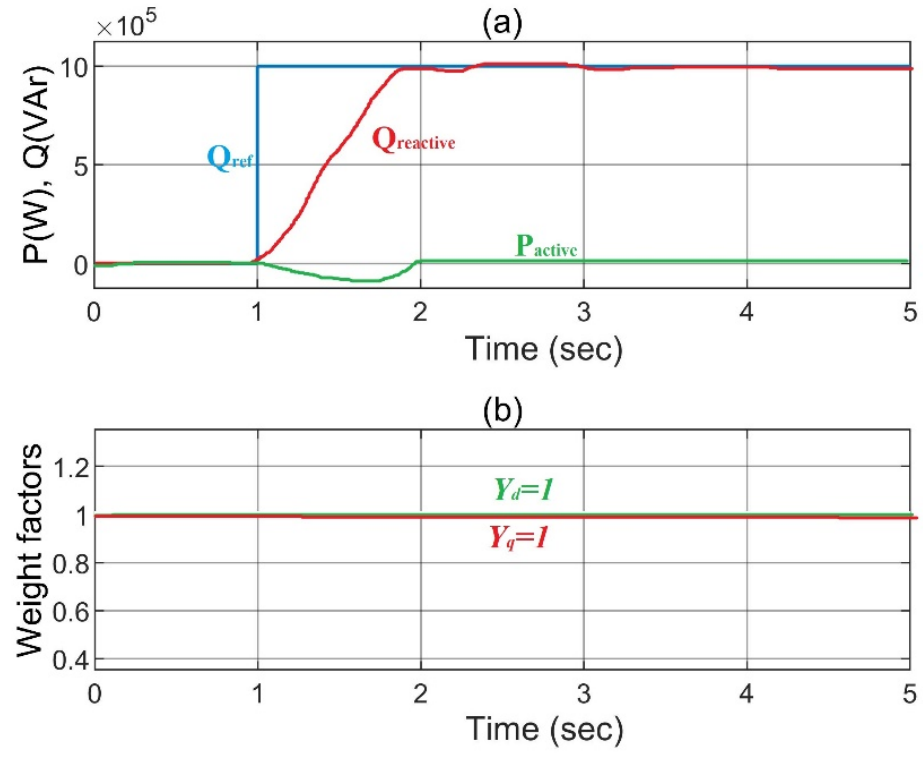
Figure 10. Step-response of FCS-MPC during fixed WFs. ( a ) Active power and Reactive power ( b ) Dynamics of WFs.